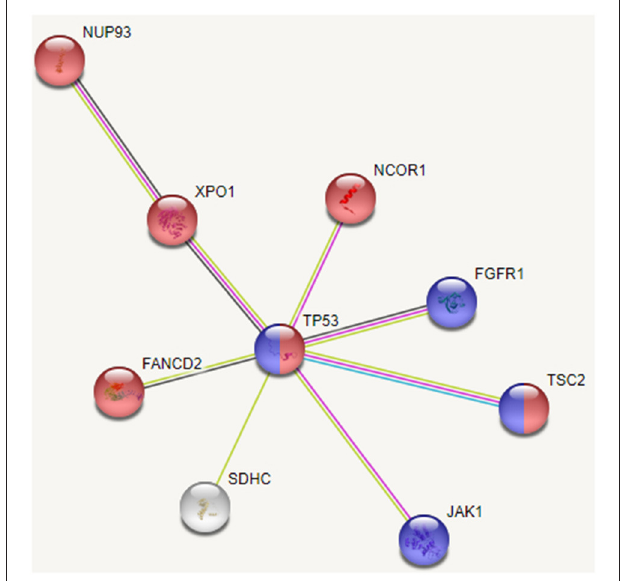
FIGURE 7 | Interaction between recurrently mutated genes from STRING database. Pathway enrichment analysis of these mutated genes indicate that cell cycle (shown in red) and PI3K/AKT (shown in blue) pathways are